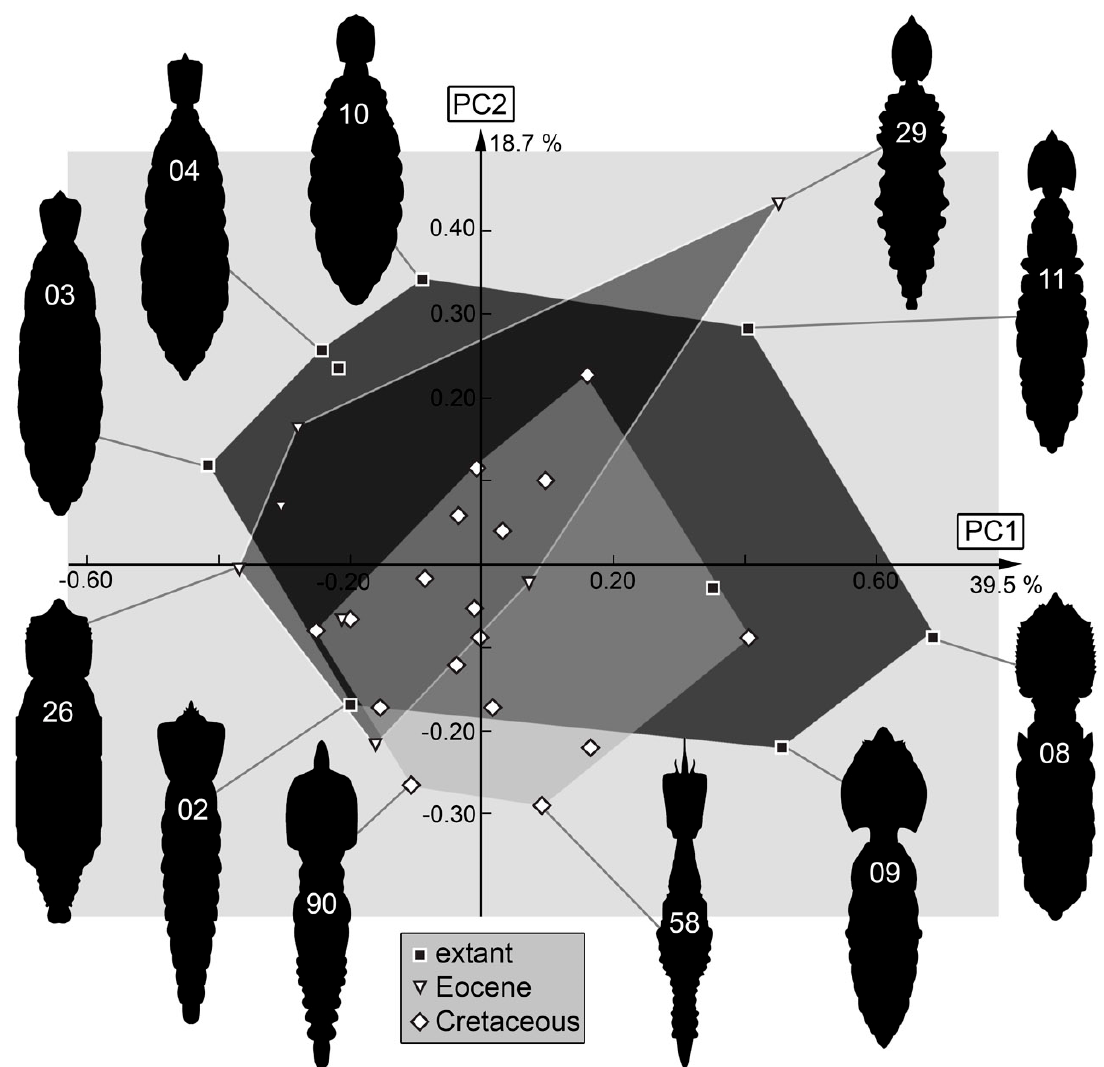
Figure 36. Scatterplot of PC2 vs. PC1 values of body shapes without stylets.